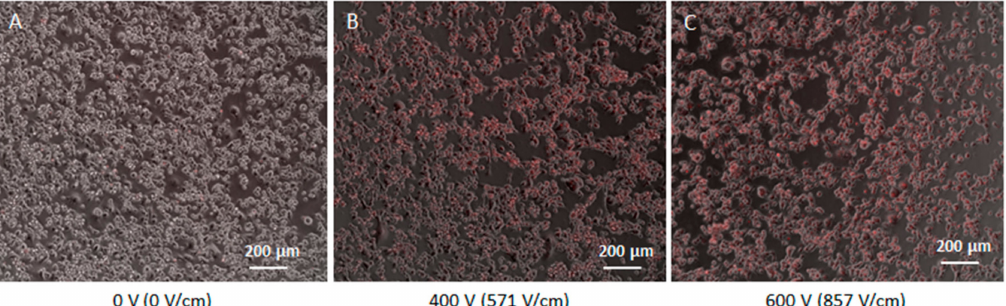
Figure 11. Monolayer cell culture after the treatment with 8 voltage pulses with amplitude